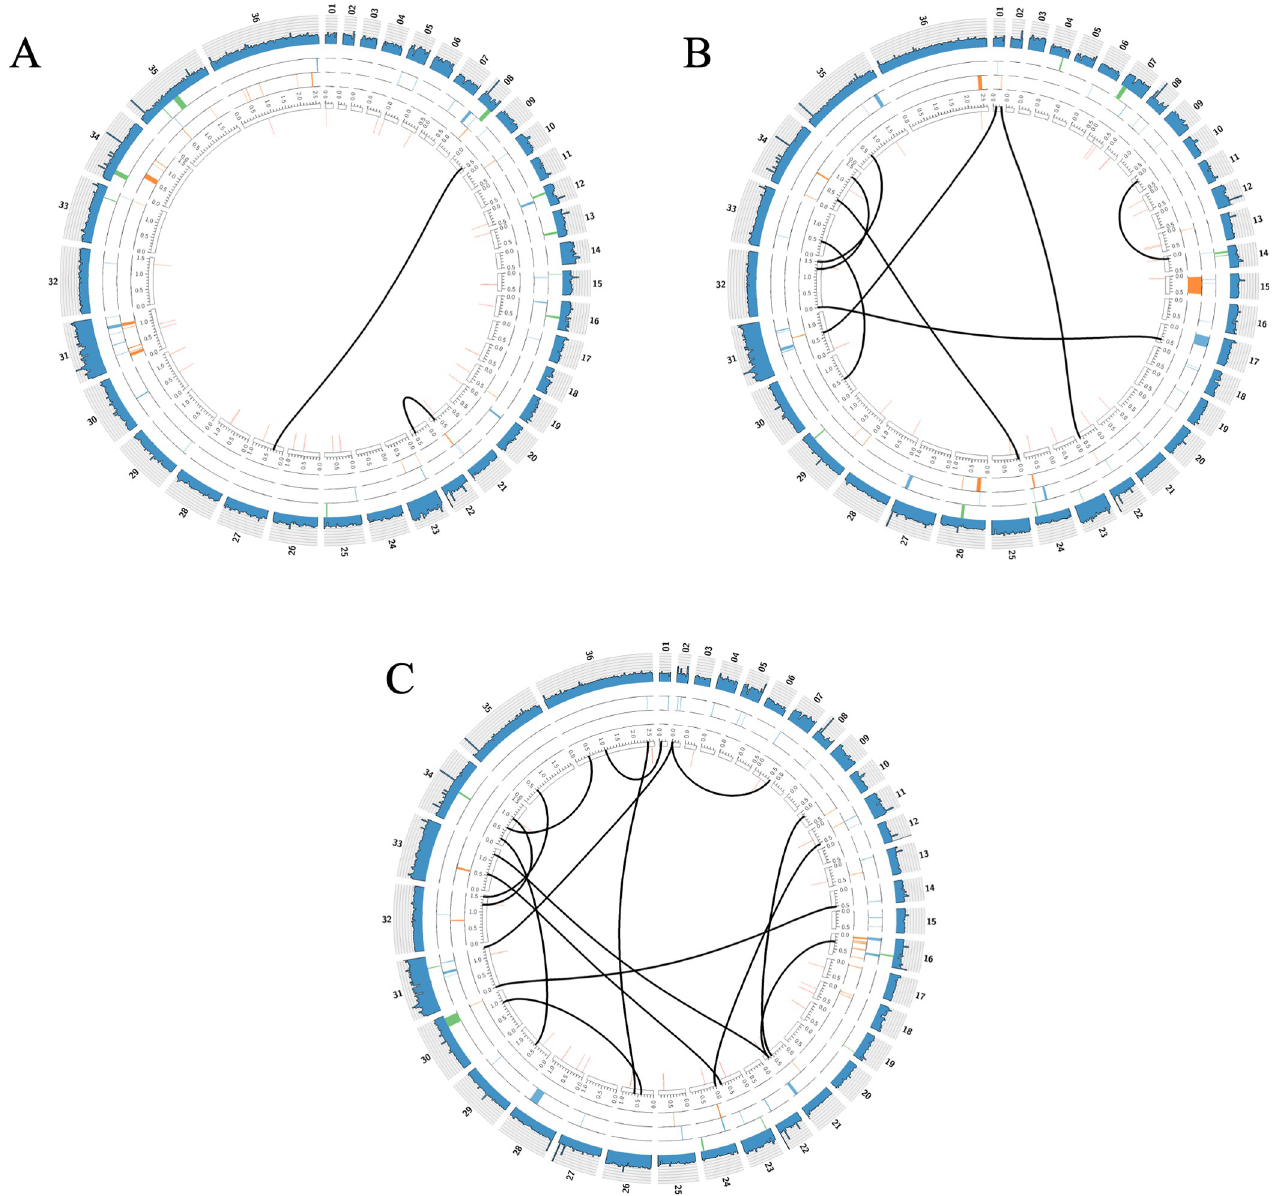
Fig 5. Whole-genome-scale structural variations specific for L . turanica strains. (A) Single infections MN strains (coverage track exemplified by MNR4). (B) Mixed infections LEM strains (coverage track exemplified by KD51). (C) Mixed infections TM strains (coverage track exemplified by 9105). Outer histograms (blue) show chromosome read coverage, inner tracks with highlights show the inversions (green), deletions (blue), duplications (orange), and insertions (red). Black lines show inter-chromosome translocations.